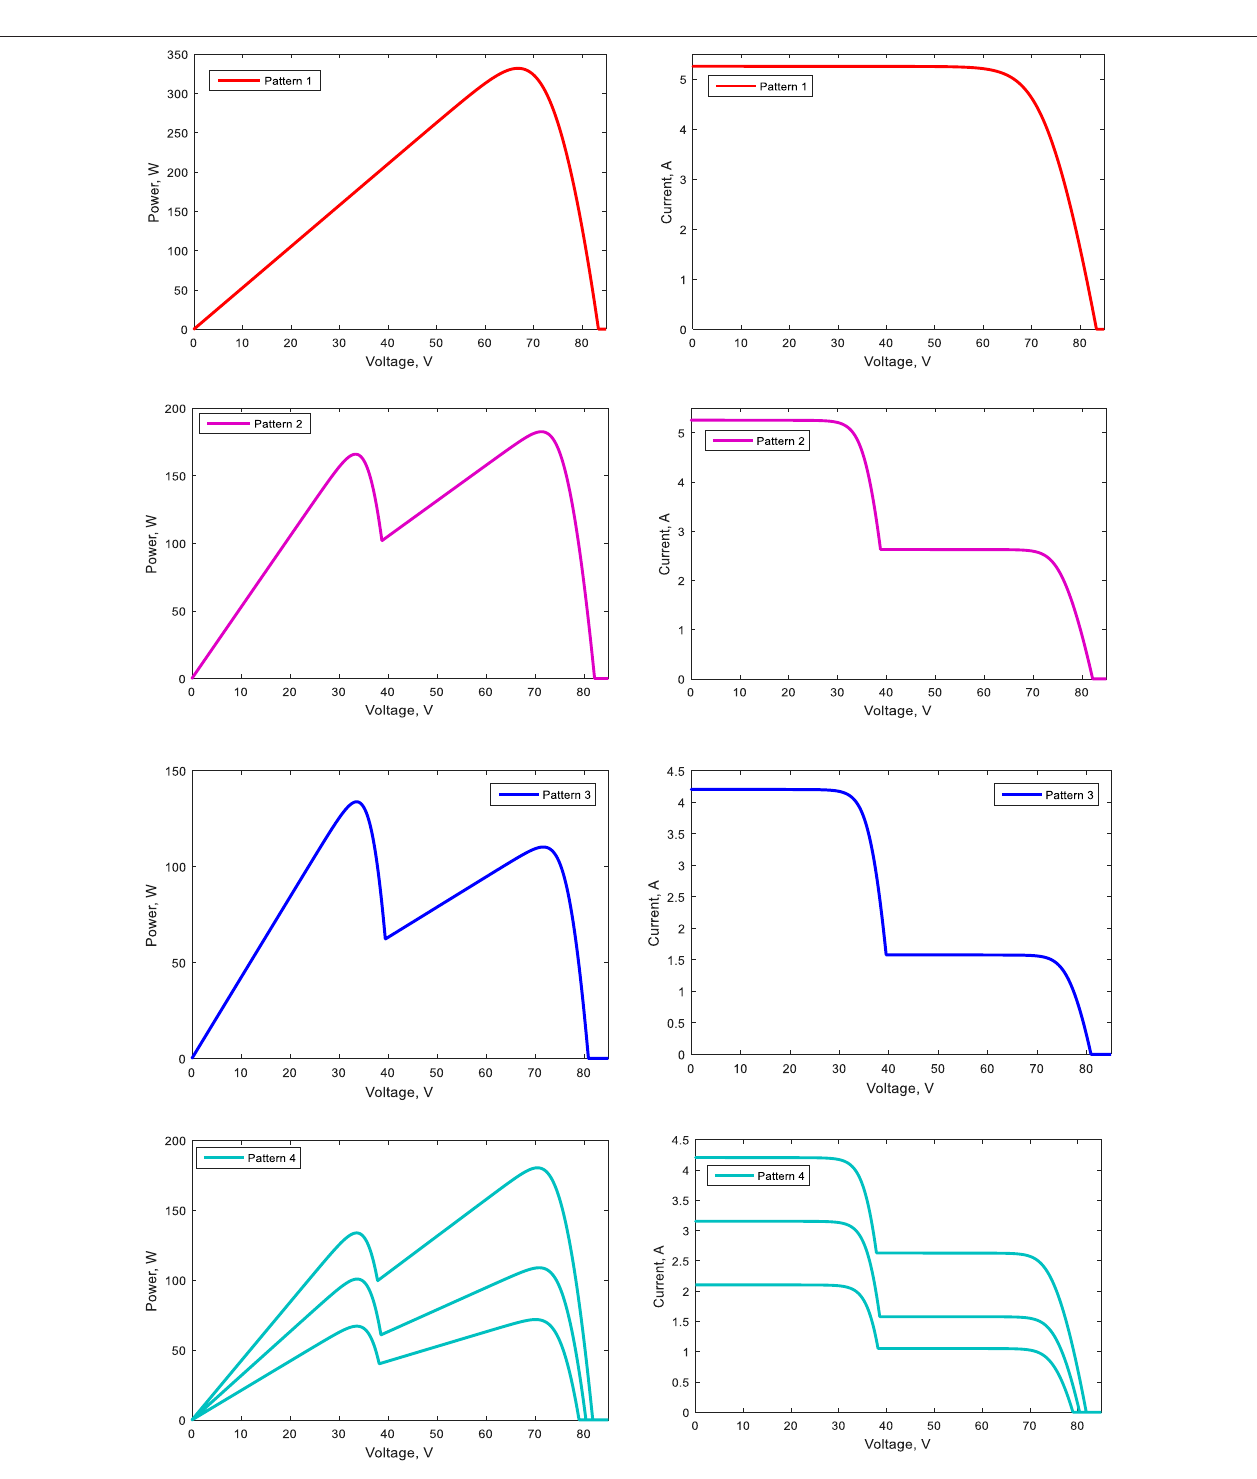
FIGURE 1 | PV ’ s P – V and I – V characteristics at the four patterns.